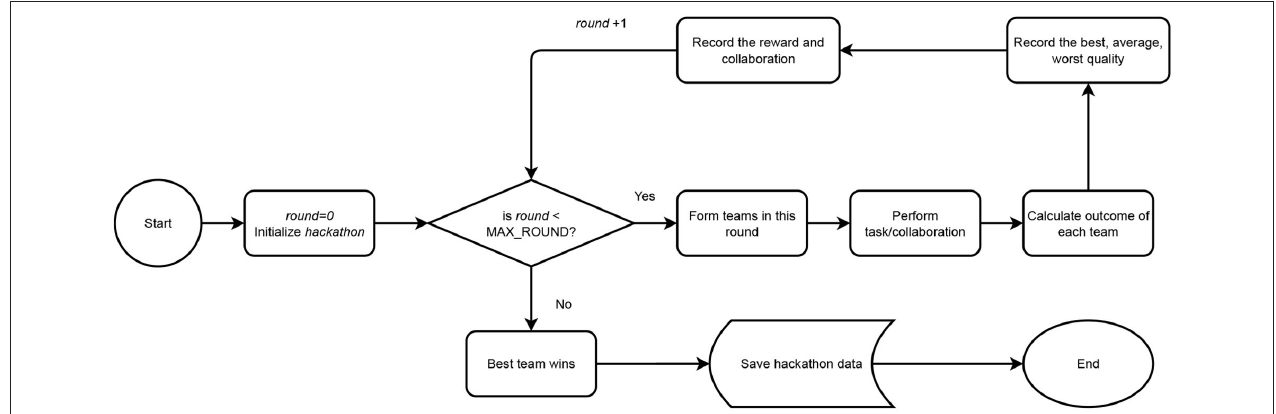
FIGURE 1 | System architecture displaying the steps taken by the system in accordance with the hackathon design starting from the initialization of the agents and proceeding to the formation of teams assessed across ten